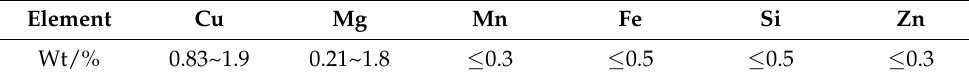
Table 1. Typical chemical components of 2A12 aluminum alloy.